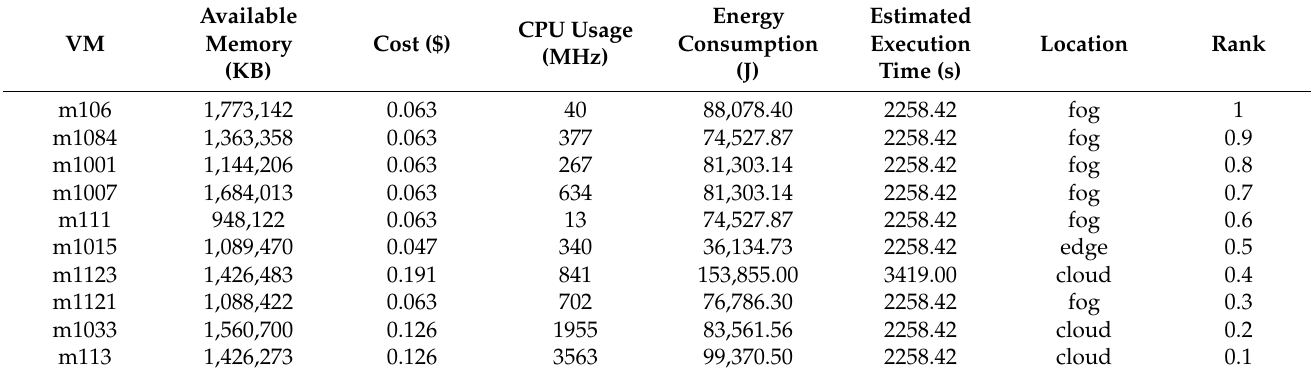
Table 19. Optimization results Task 334016 for a memory availability and CPU utilization use